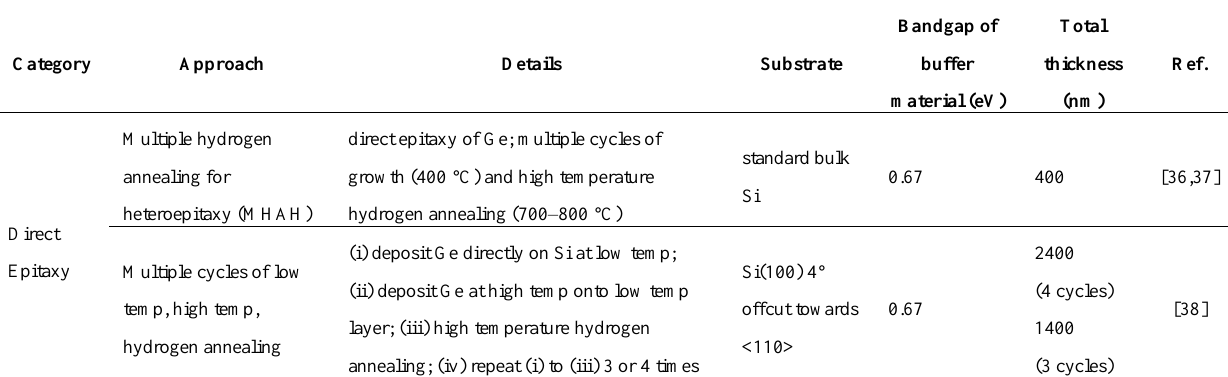
Table 1. Summary of buffer architectures for Ge epitaxy on Si-based